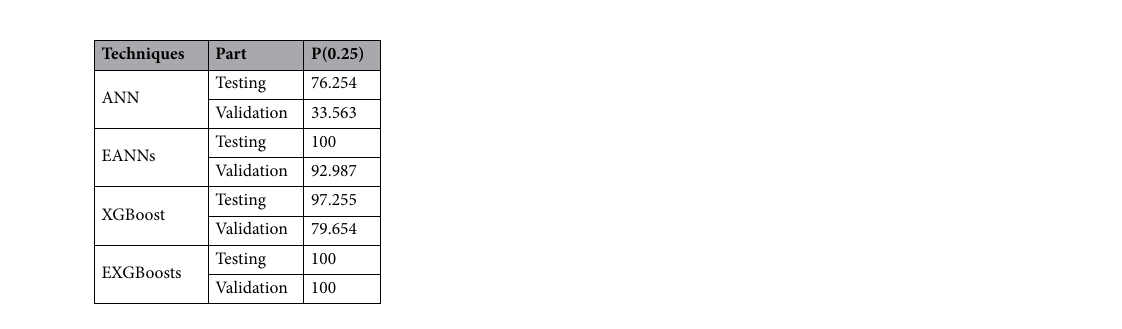
Table 10. Estimation level at 25% in testing and validation